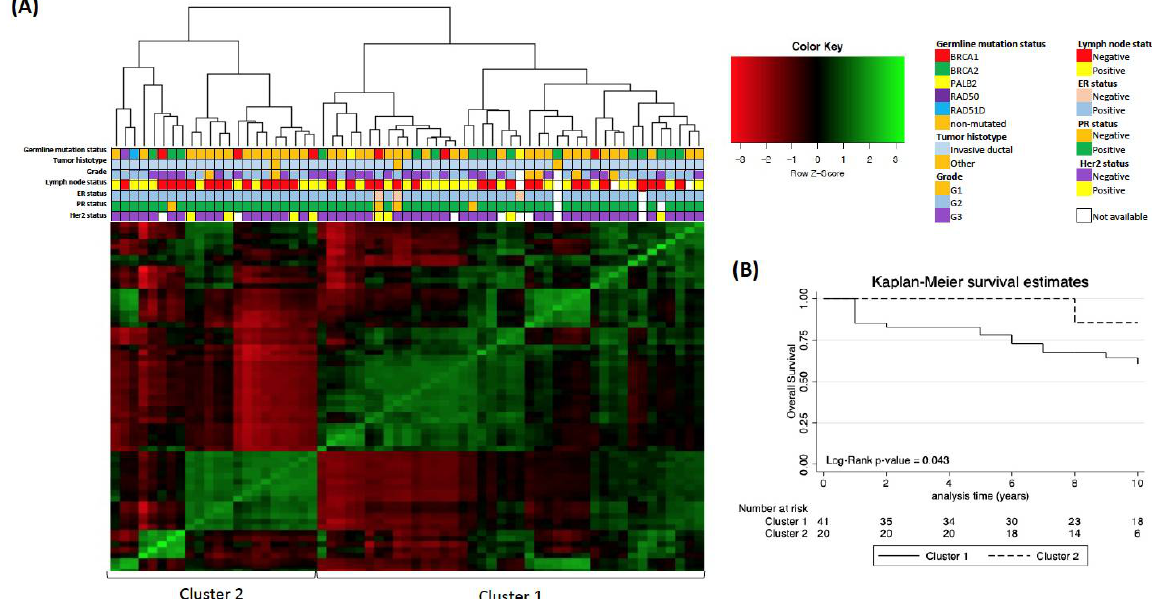
Figure 2. ( A ) Heatmap of the 2000 most variable transcripts among MBC cases showing two clusters (Cluster 1 and Cluster 2). Germline mutation status and pathological characteristics are reported for each case. ( B ) Kaplan–Meier survival analysis suggesting worse overall survival for the cases in Cluster 1 compared with the cases in Cluster 2.